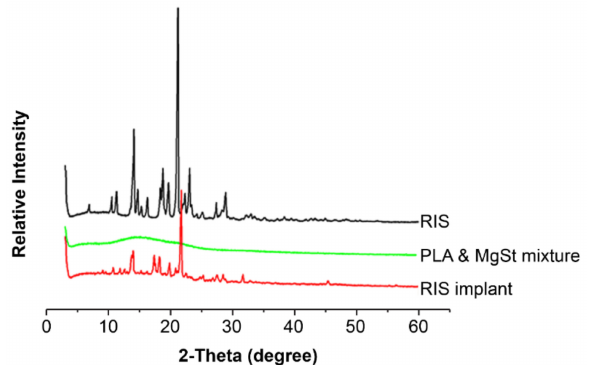
Figure 4. X-ray diffraction pattern between risperidone and excipients. RIS, risperidone; PLA, polylactic acid; MgSt, magnesium stearate.